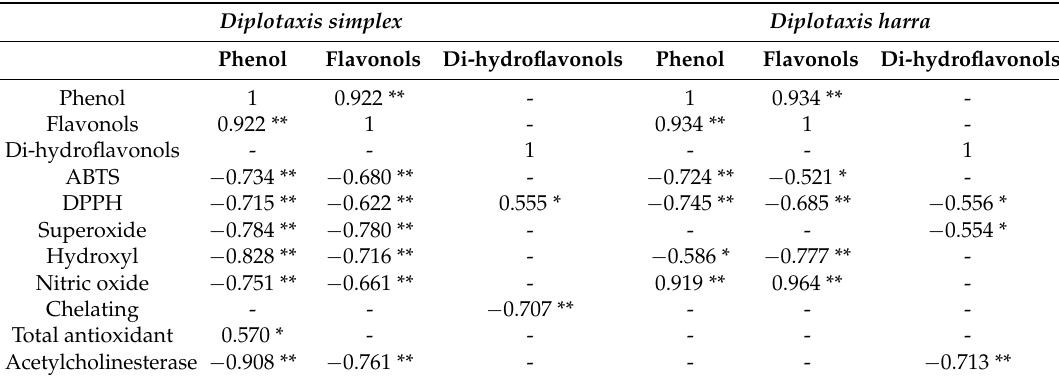
and after contact with artificial saliva